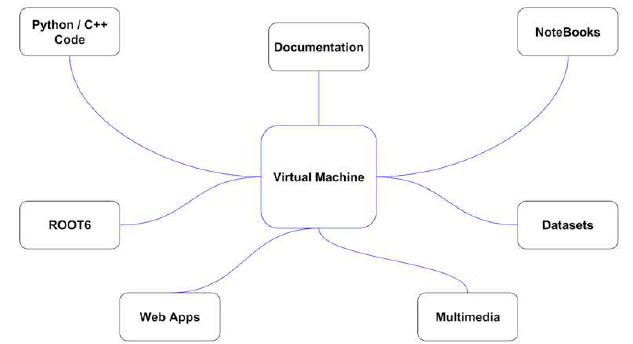
Figure 4. Overview of the ATLAS Open Data Virtual